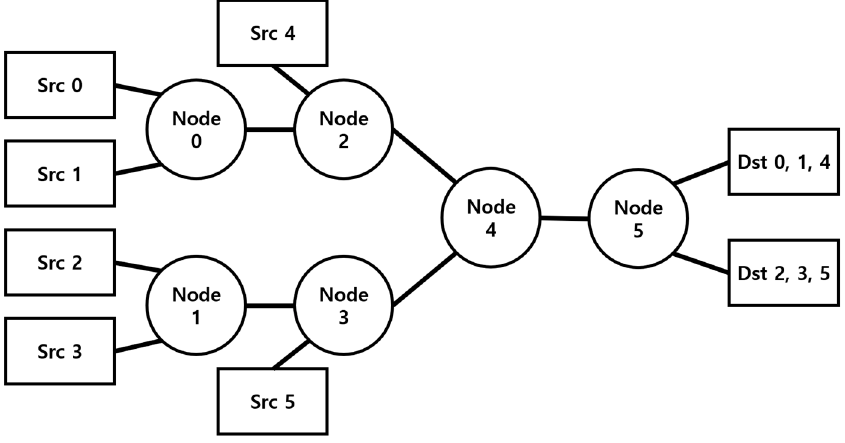
Figure 10. Topology 2. Table 7. Packet generation scenario in topology 2.